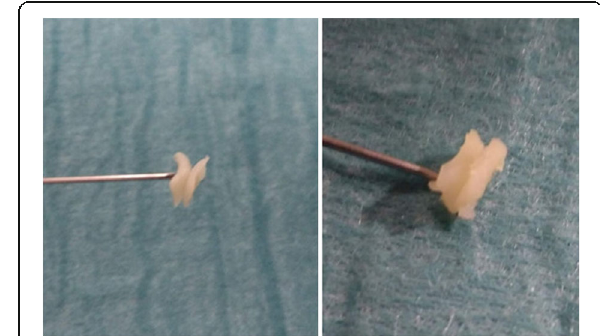
Fig. 3 Steps of IBCG: a circumferential splitting, b insertion of IBCG as grommets, and c , d graft in